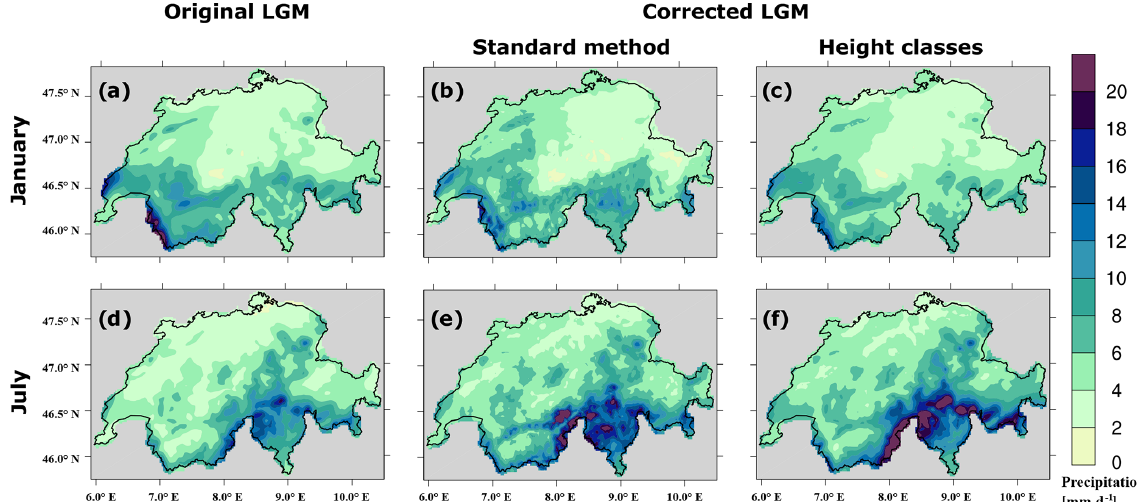
Figure 11. Monthly climatology of 30-year precipitation over Switzerland during the LGM. Panel (a) represents uncorrected precipitation intensity in January; panel (b) is the same as (a) but corrected using the standard EQM; panel (c) is the same as (b) but using the new method; panels (d) , (e) , and (f) are the same as (a) , (b) , and (c) but for July,